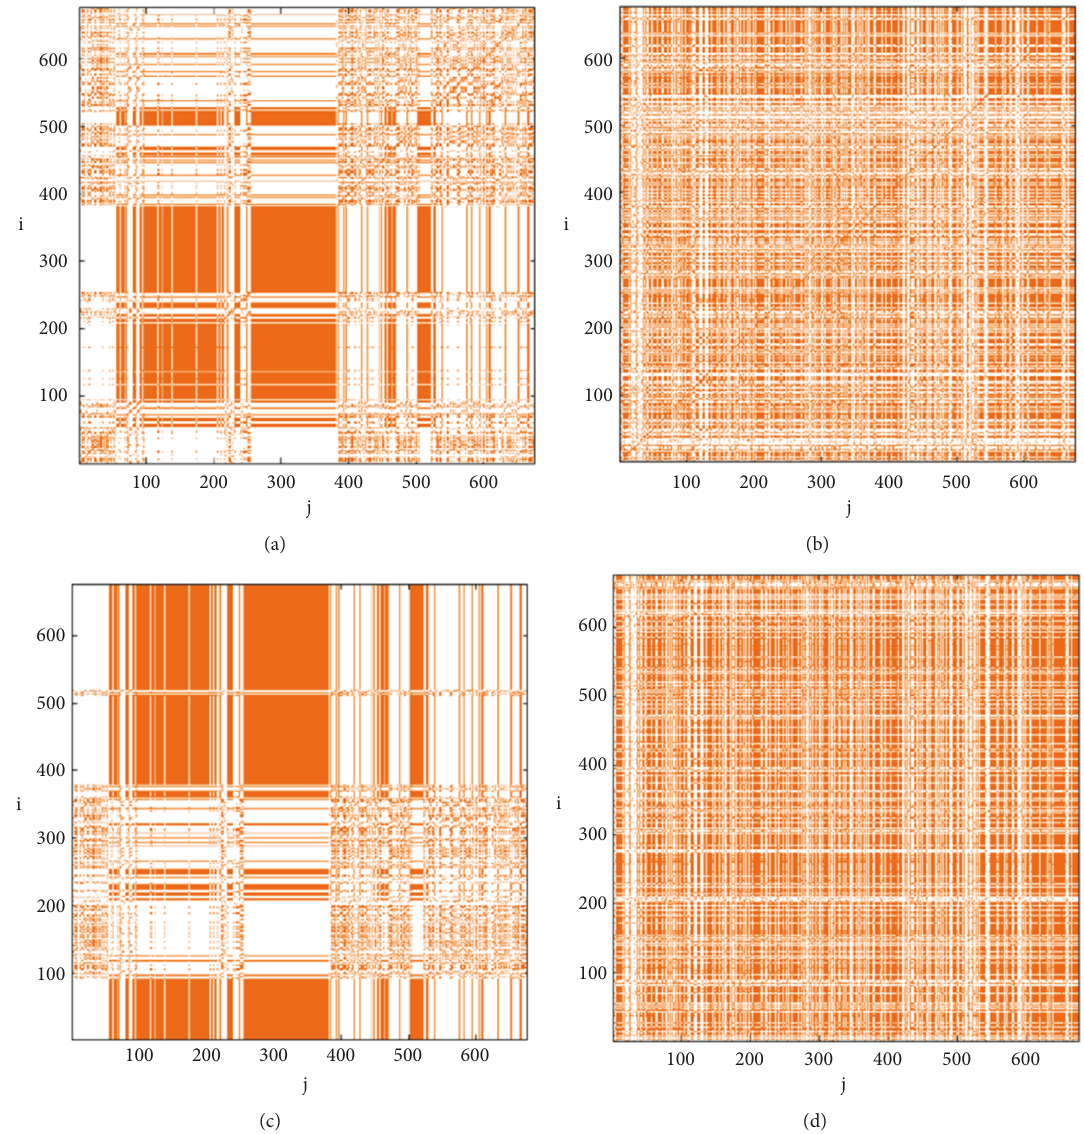
Figure 1: Recurrence plots (RP) of verbal expressions and grammar coming from an individual (Panels (a) and (b)) and dyads (Panels (c) and (d)). Panel (a) shows a RP with a delay of 1 and an embedded dimension equal to 1, in which it is possible to observe a diagonal line and coloured squares that show repetitions—in speech—of certain grammatical structures (e.g., verb, pronoun, adjective, article, adverb, among others) while the individual was interacting communicatively. Panel (b) shows a RP in which the original verbal expressions were randomized (reshuffled). Randomization destroyed the sequences and, therefore, the coherence with which the behaviours was appearing while the interaction was taking place. Thus, the RP represented by Panel (b) shows a random pattern of behaviours, in which predictability is very low, there is maximum entropy, and there is no system stability at all. Panel (c) shows a RP generated from a dyadic interaction in which C-RQA was applied. This RP and its randomized version (Panel (d)) have a characteristic that differentiates them from the RPs in panels (a) and (b). This is because the diagonal identity line is not present. Being two systems that interact, the diagonal line of identity tends to